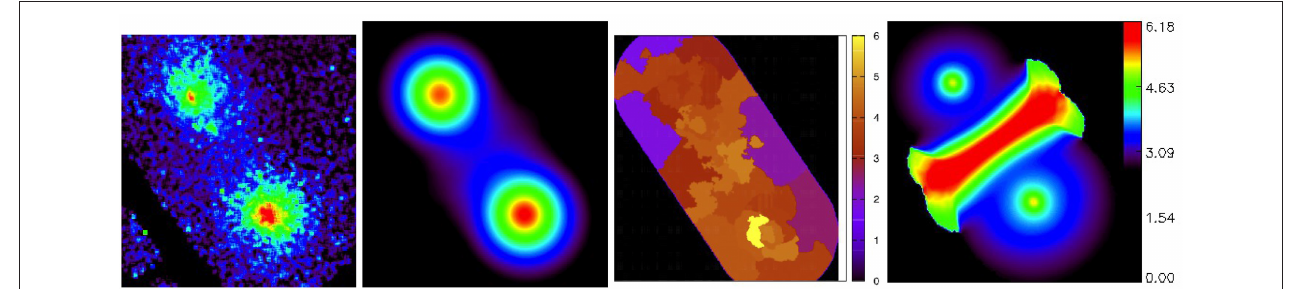
FIGURE 8 | Images of X–ray surface brightness and projected temperature (in units ofkeV) of A1750 from Chandra observations and from the FLASH simulation with an impact velocity of 1400 kms − 1 , which is the best match to observations (Molnar et al., 2013b). From left to right: exposure corrected X–ray surface brightness maps from observations and simulation, projected temperature maps from observations and